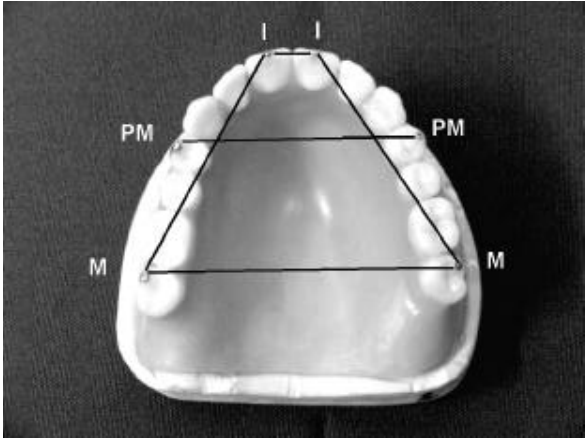
FIGURE 1 - Transverse and anteroposterior teeth